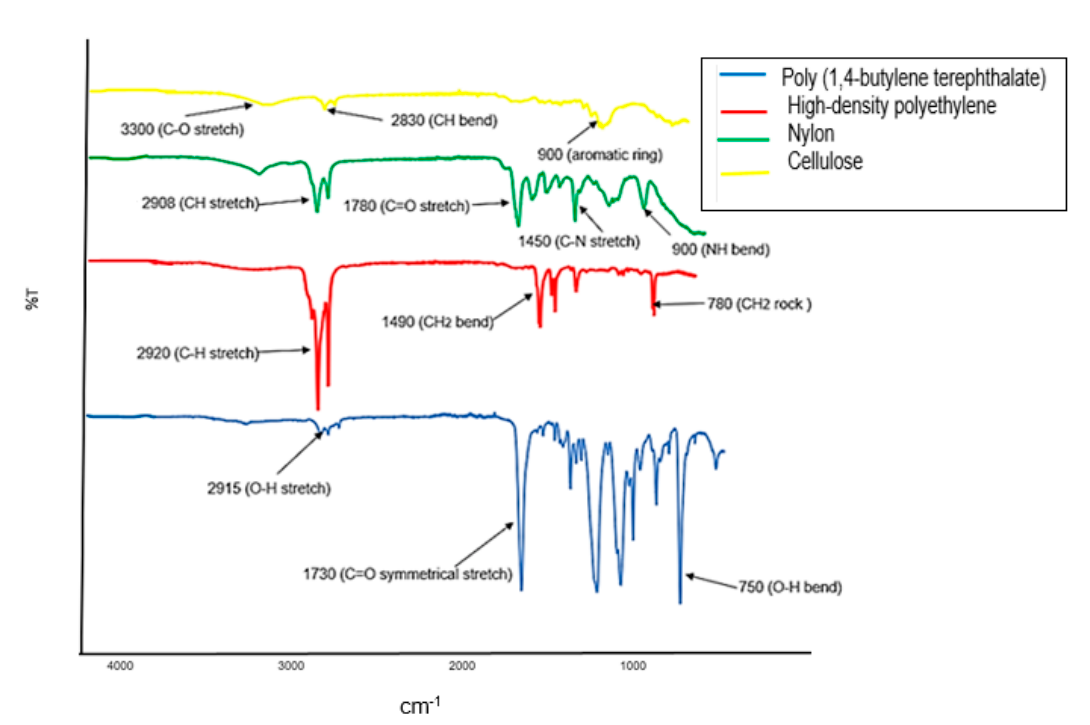
Figure 6. ATR-FTIR spectra of microplastics obtained from a wastewater influent sample.